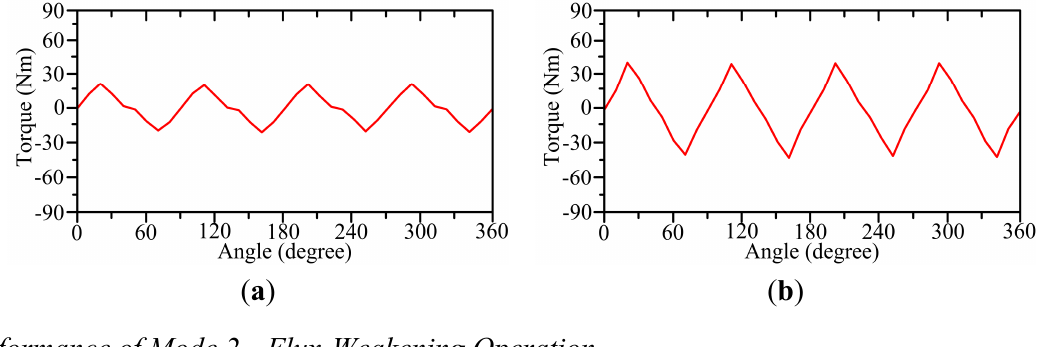
Figure 12. Cogging torque waveforms at bipolar conduction scheme: ( a ) rated DC-field excitation; and ( b ) strengthened DC-field excitation.